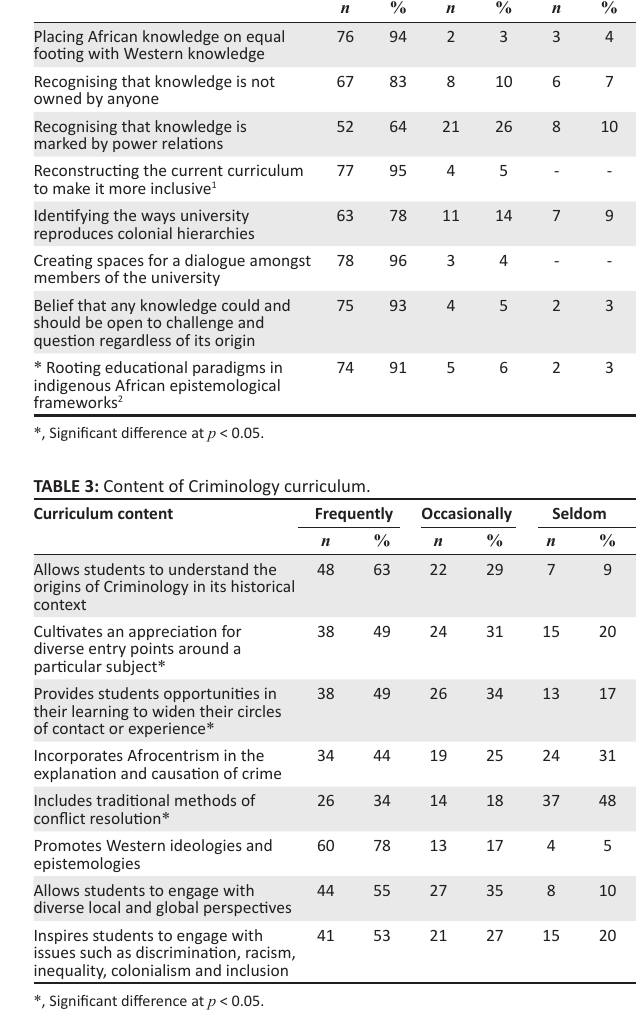
TABLE 1: Biographic information of respondents. Biographic variables